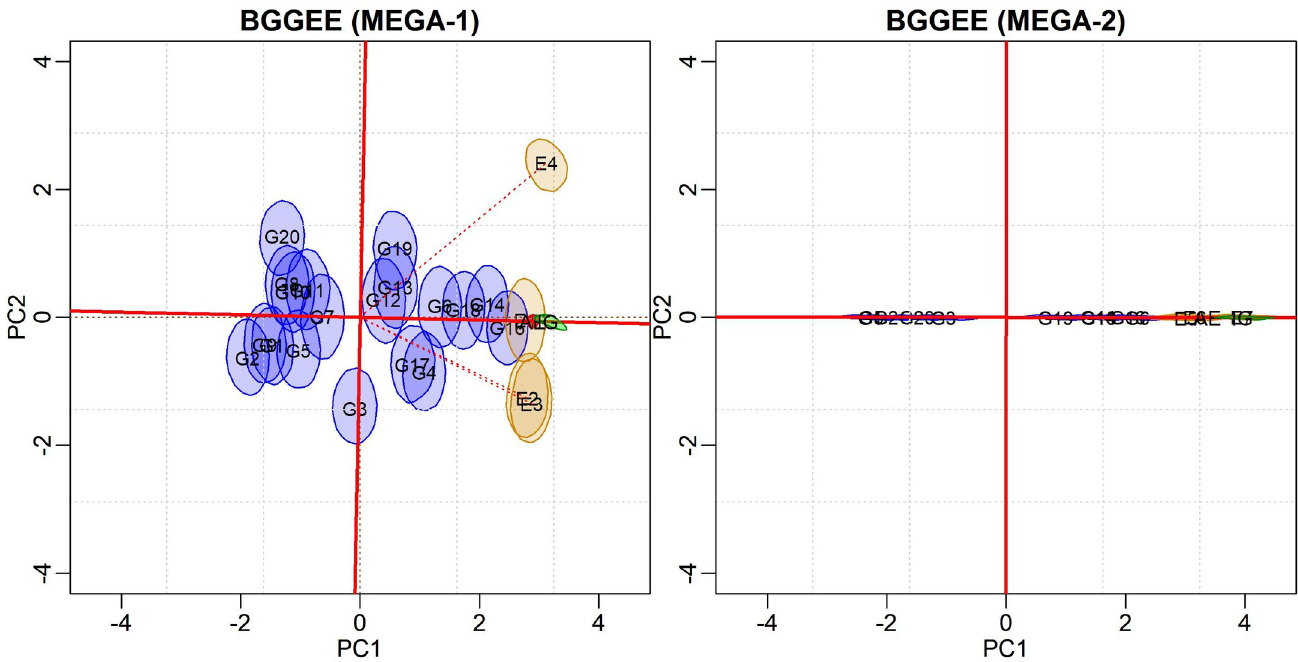
Fig 5. Biplot for the BGGEE (Bayesian-GGE entropy) model with 95% credible regions, including the genotypic and environmental scores for the average environment (red) and ideal genotype (green) for to the two defined mega-environments .